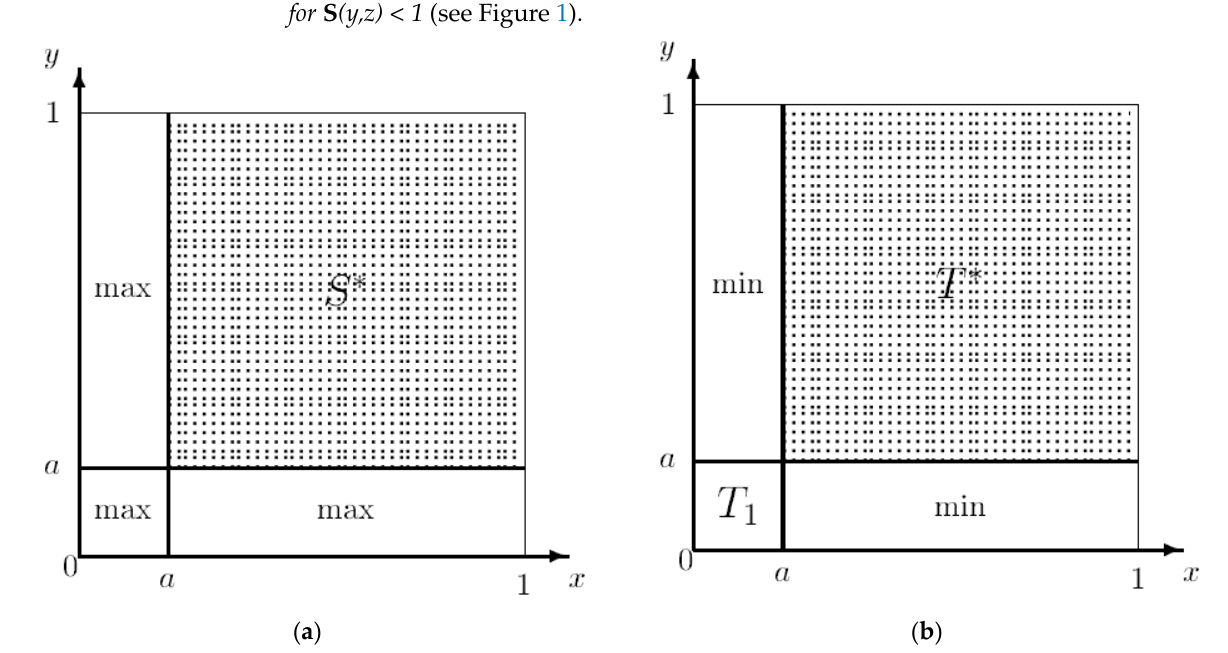
Figure 1. The pair ( S , T ) satisfying the conditional distributivity: ( a ) Corresponding t-conorm ( b ) Corresponding t-norm.